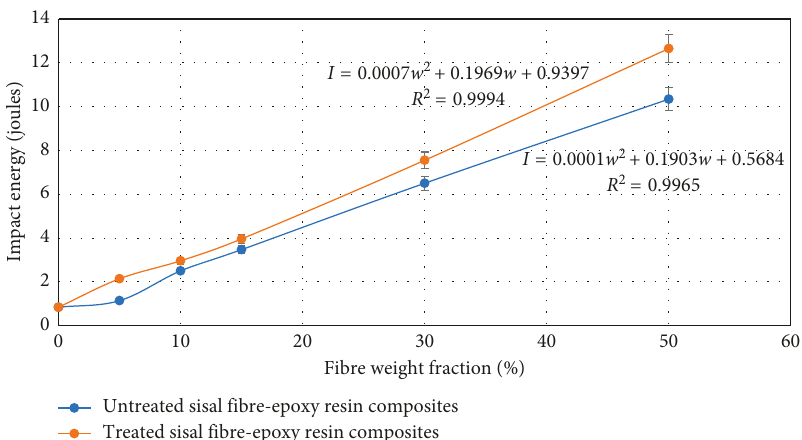
Figure 6: A plot of the average values of impact energy versus fibre weight fraction % for treated and untreated sisal fibre-epoxy resin reinforced composites. Table 2: Barcol values of hardness for pure epoxy resin and treated and untreated sisal fibre-epoxy resin composites. Values of hardness for the untreated sisal fibre-epoxy Values of hardness for the treated sisal resin composites (Barcol units-BU) Weight % of the reinforcing fibre